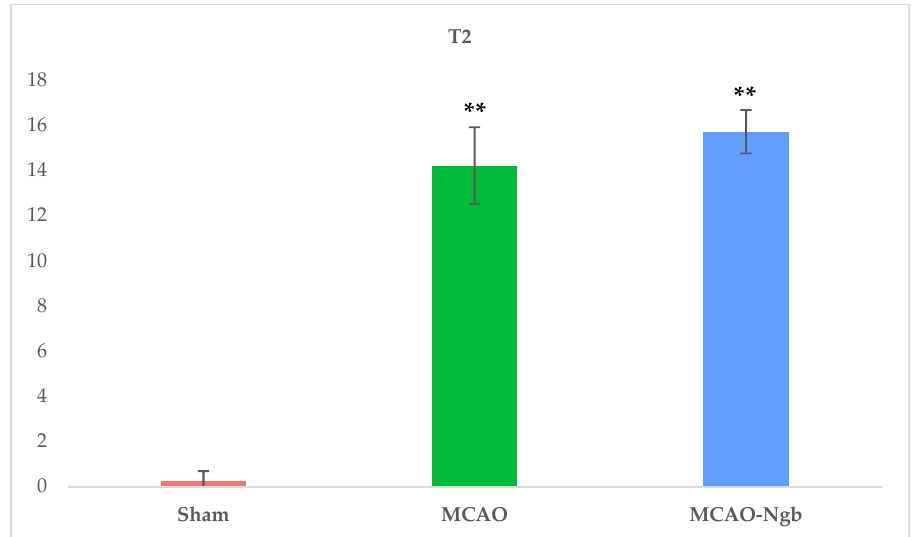
Figure 7. Mean values of the volume of the infarcts in sham, MCAO, and MCAO-Ngb groups cal- culated from the T2 neuroimages. Data have been calculated using ImageJ software, and are ex- pressed in arbitrary units. Data are average values of six experimental animals in each group (** p < 0.01).